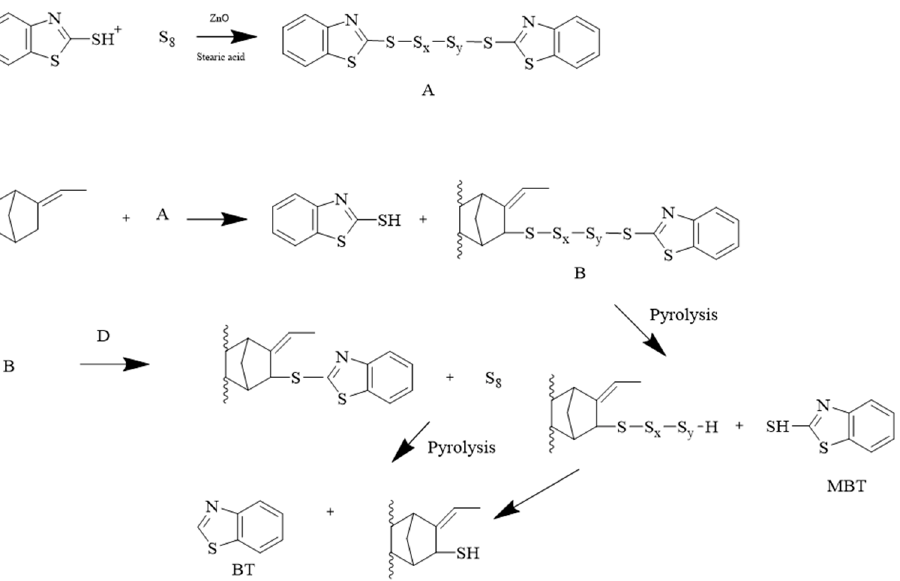
Scheme 3. Crosslinking mechanism for EBN-EPDM with benzothiazole-based accelerators and mechanism of formation of benzothiazole from ENB monosulfide residue from EPDM vulcanized with sulfur and 2-mercaptobenzothiazole accelerator